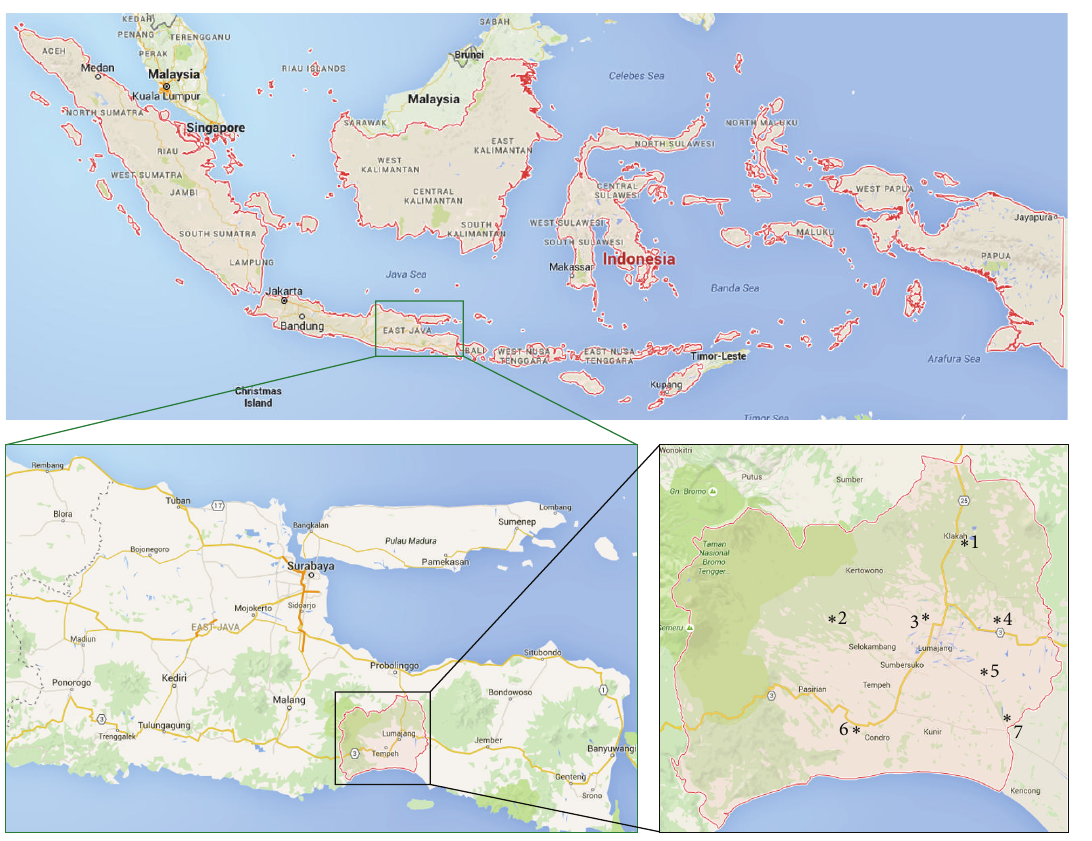
Figure 1: Location of banana’s sampling in Lumajang, East Java, Indonesia. Asterisk ( ∗ ) refers to sampling spot area (modified from Google Maps) such as Kedung Jajang (1), Pasru Jambe (2), Sukodono (3), Randu Agung (4), Tekung (5), Tempeh (6), and Yosowilangun